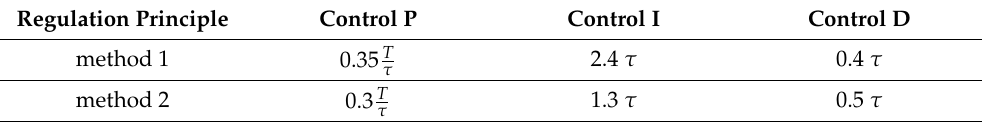
Table 1. Calculation of PID controller